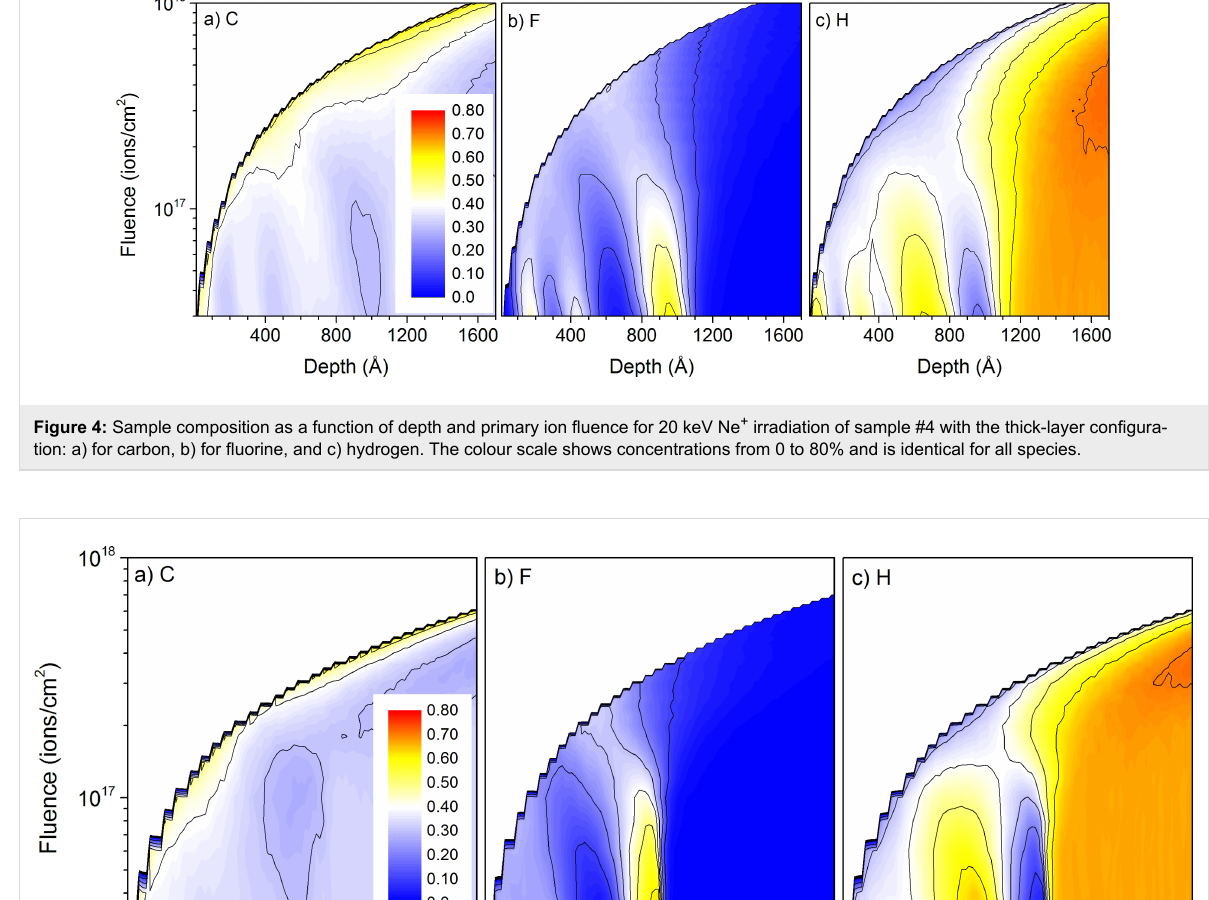
ly high diffusion coefficients of neon and argon in the four gases in the different